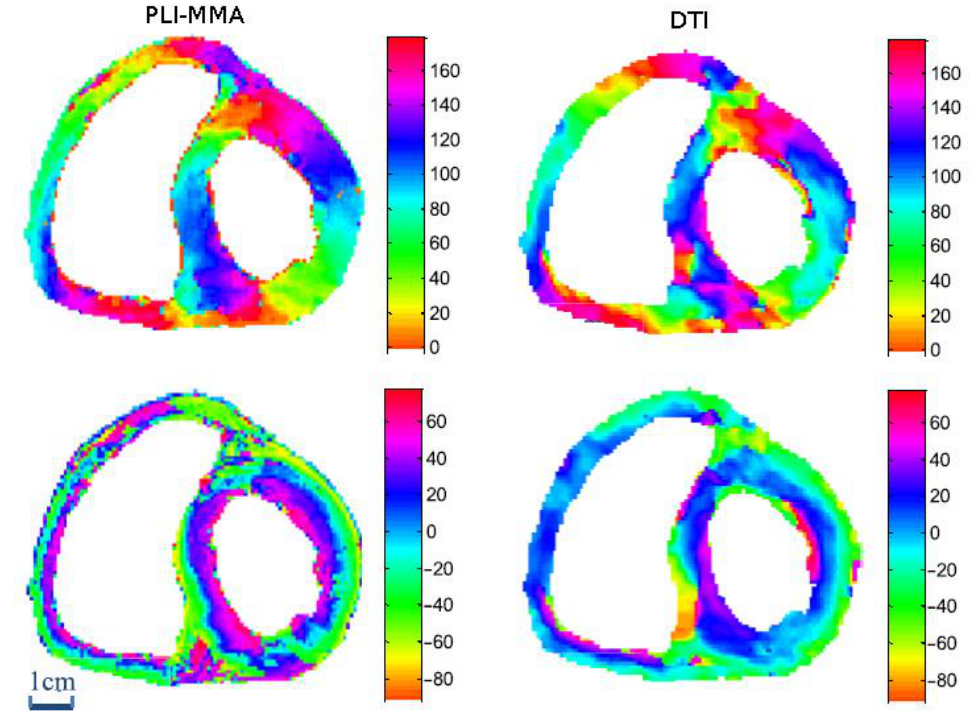
Figure 4. Comparison of the registered DTI and the downsampled PLI maps of an equatorial heart section. Upper row: azimuth maps; Lower row: elevation maps. For the sake of comparison, the representation in cartesian coordinates of PLI elevation maps was transformed in cylindrical coordinates that are the rule for DTI representation.